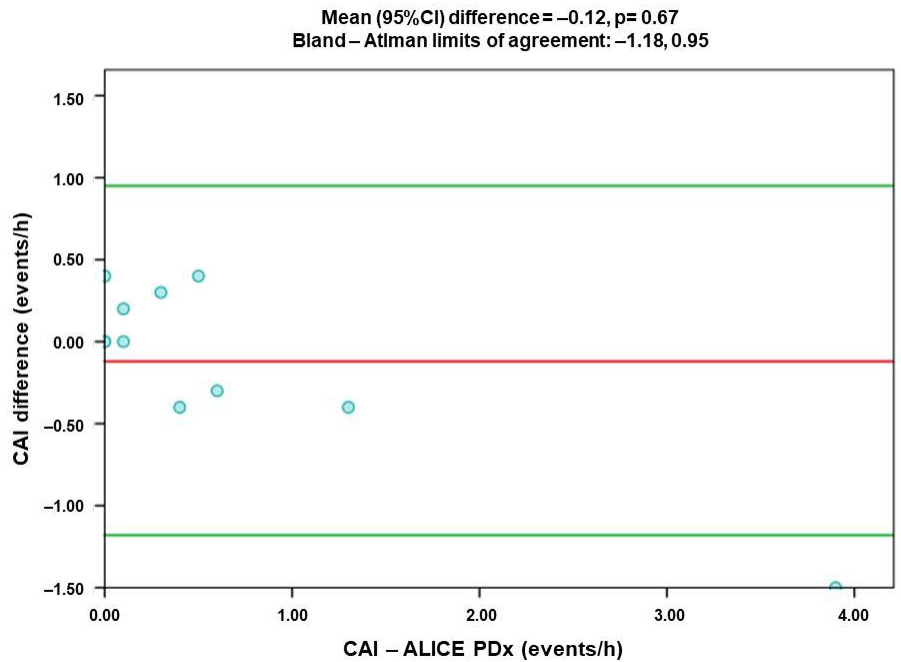
Figure 2. Bland-Altman plots. Distinction between the CAI-Alice PDx plotted against the two devices’ CAI difference ( n = 11). The red line presents the mean difference, while the green ones reveal the limits of agreement. CAI: central apnea index.